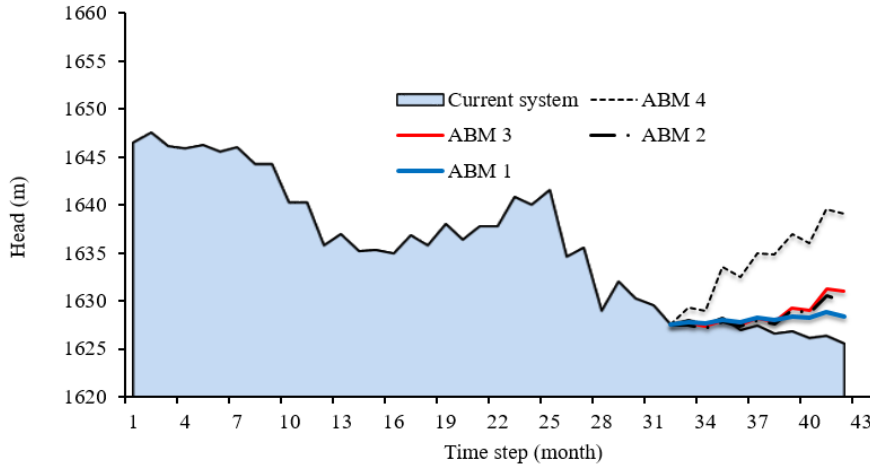
Figure 8. Aquifer hydrograph after applying alternative management